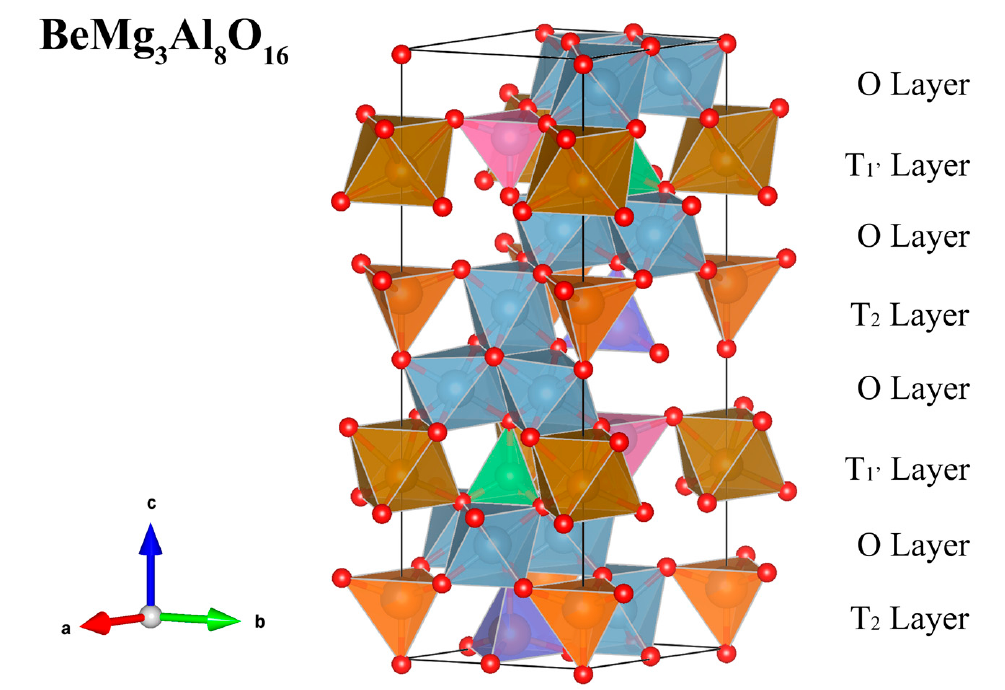
Figure 1. Polyhedral representation of the magnesiotaaffeite-2N’2S crystal structure. The pink and green tetrahedrons in the T 1 ′ layers have opposite directions, and the same goes for the orange and purple tetrahedrons in the T 2 layers.